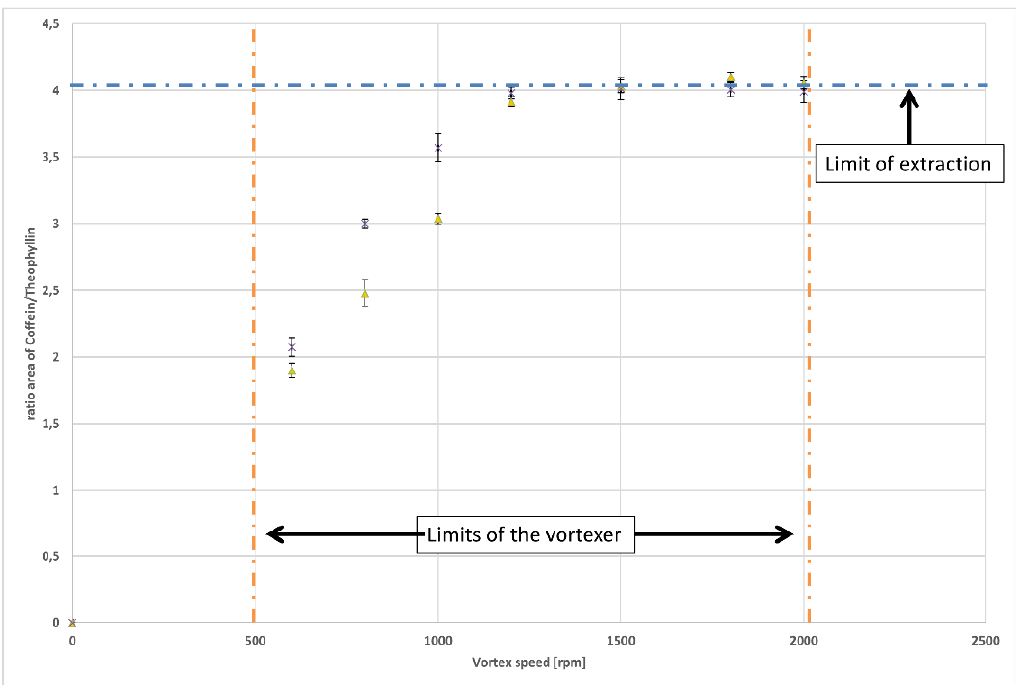
Figure 3. Results of the automated liquid-liquid extraction methodology. Noteworthy are the short extraction times of 5 to 10 s and completeness of extraction at 1200 rpm. Table 2. Results of the automated extraction of chemical warfare agents VX, VG and HD at 5 s extraction time and 1200 rpm vortex